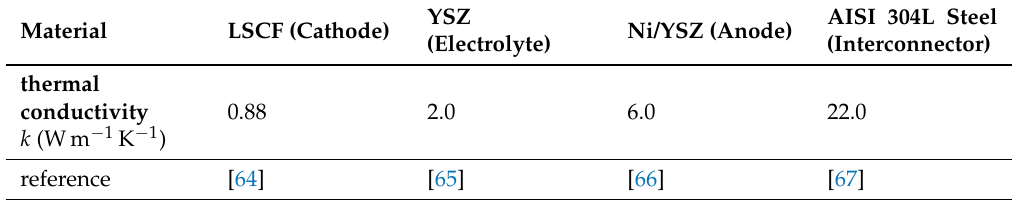
Table 10. Thermal conductivities of solid